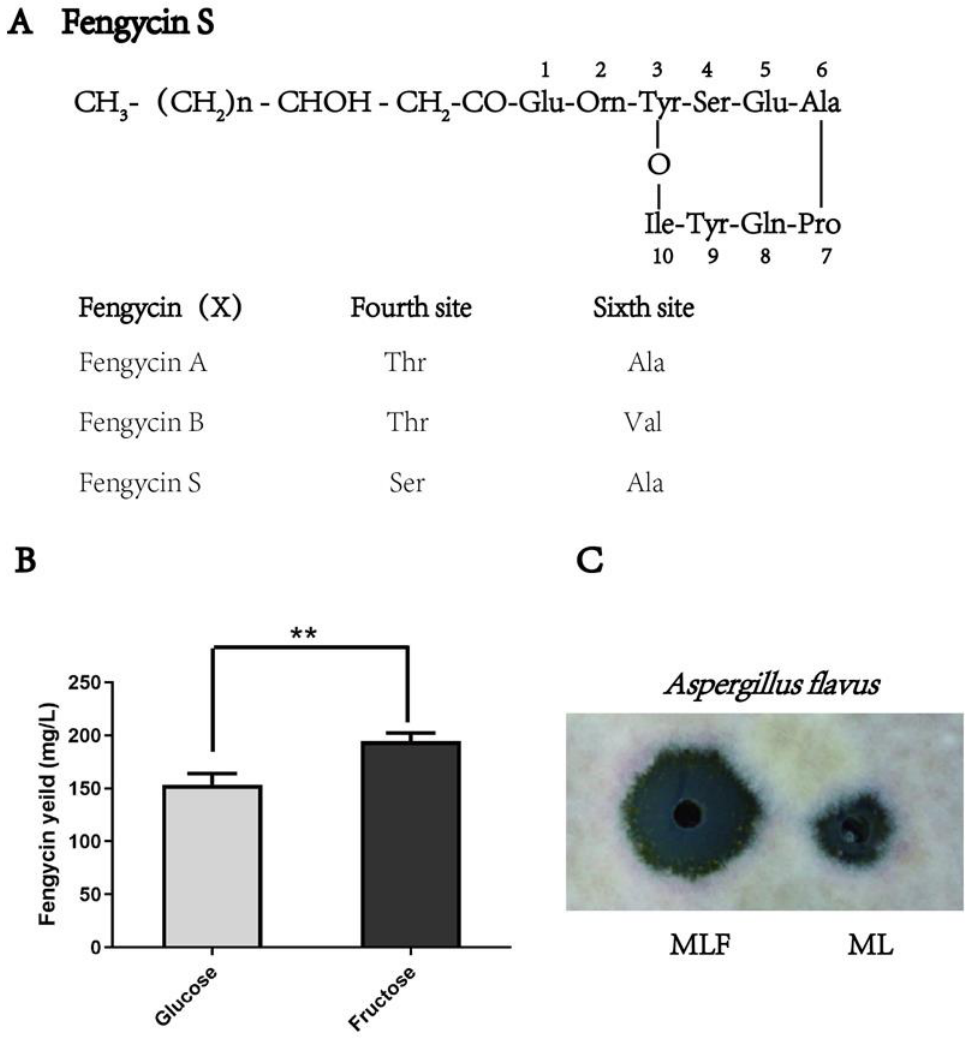
Figure 1. ( A ) The molecular structure of fengycins ( B ) The effort of fructose on the yield of fengycin ** means significant differences ( C ) The antimicrobial activity of the culture supernatant of ML and MLF against Aspergillus flavus after being fermented by B. amyloliquefaciens fmb-60.